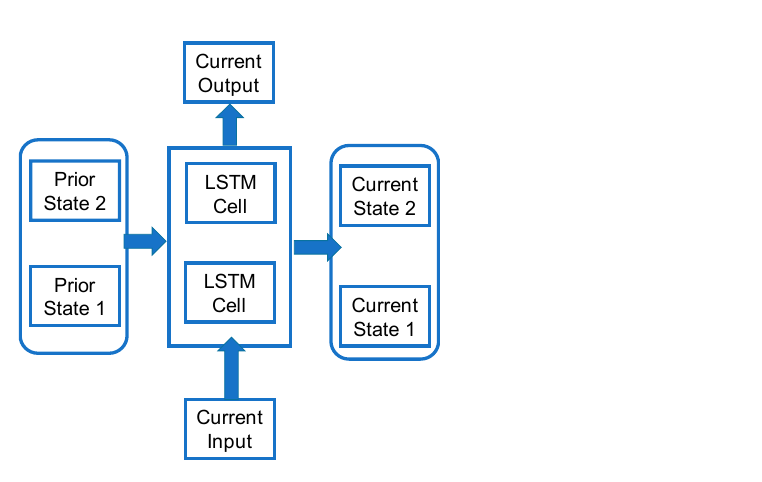
Figure 8. LSTM-RNN architecture.